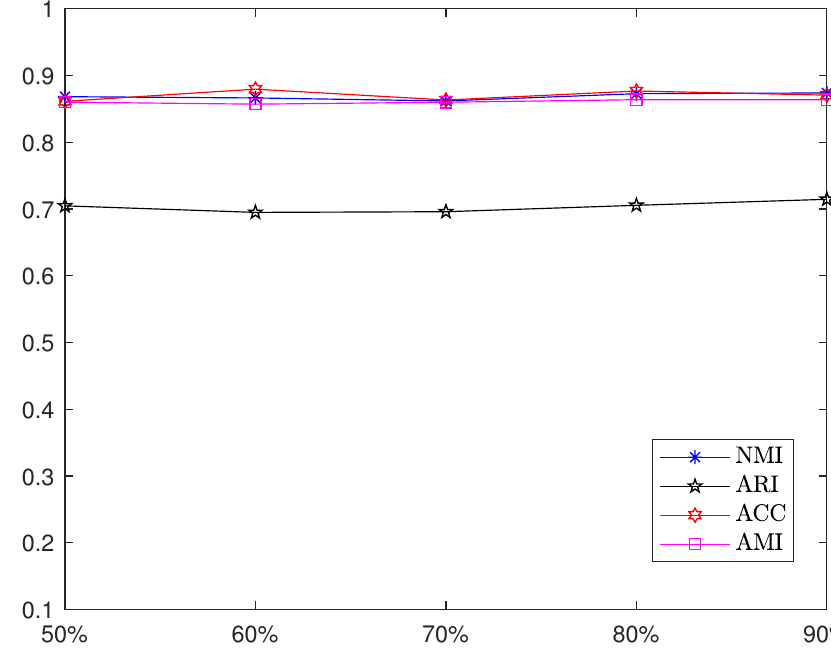
Figure 4. Results of Dermatology by 3WESP.